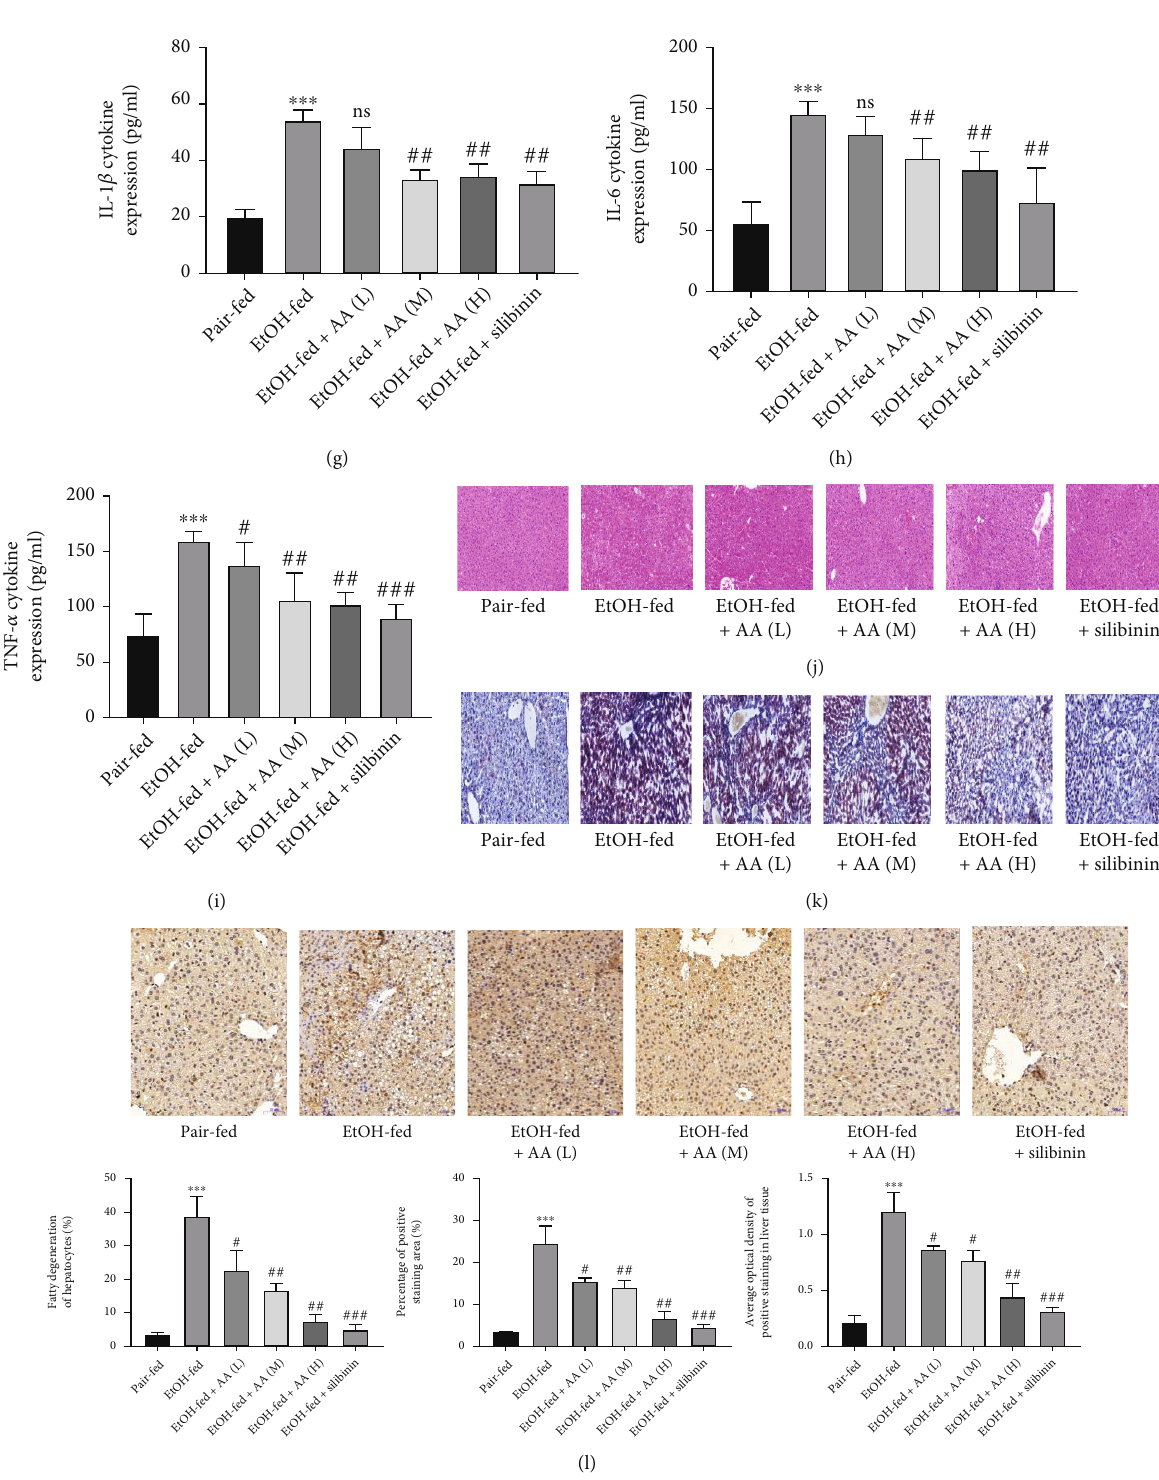
Figure 7: Asiatic acid can relieve alcoholic hepatitis in mice. (a) Body weight and (b) liver index. (c – f) The serum levels of ALT, AST, TG, and T-CHO. (g – i) The serum levels of IL-1 β , IL-6, and TNF- α . (j) Representative H&E staining of liver sections (original magni fi cation: 200x, scale bar = 50 μ m ). (k) Representative oil red staining of liver sections (original magni fi cation: 200x, scale bar = 50 μ m ). (l) Representative P-NF- κ B-p65 immunohistochemistry staining of liver sections (original magni fi cation: 200x, scale bar = 50 μ m ). ∗ P < 0 : 05, ∗∗ P < 0 : 01, and ∗∗∗ P < 0 : 001 compared with the control group. # P < 0 : 05, ## P < 0 : 01, and ### P < 0 : 001 compared with the EtOH group. The data represent the mean ± S : D : of at least three independent